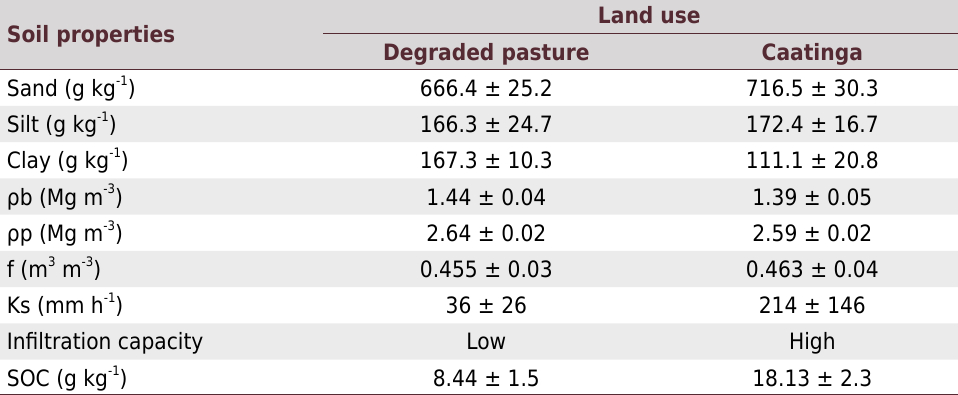
Table 1. Soil surface properties of Caatinga and degraded pasture areas Soil